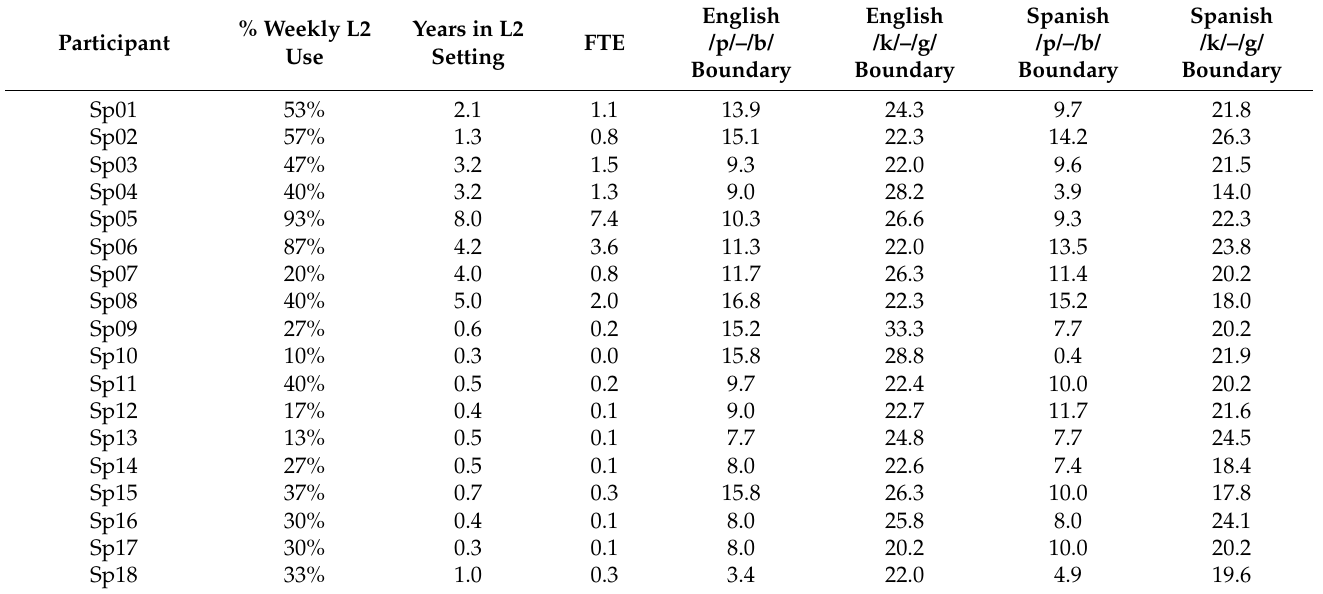
Table 4. Percentage of L2 use, years spent in an L2 setting, FTE and the category boundaries for the bilabial and velar contrasts in English and Spanish by the Spanish learners of English.